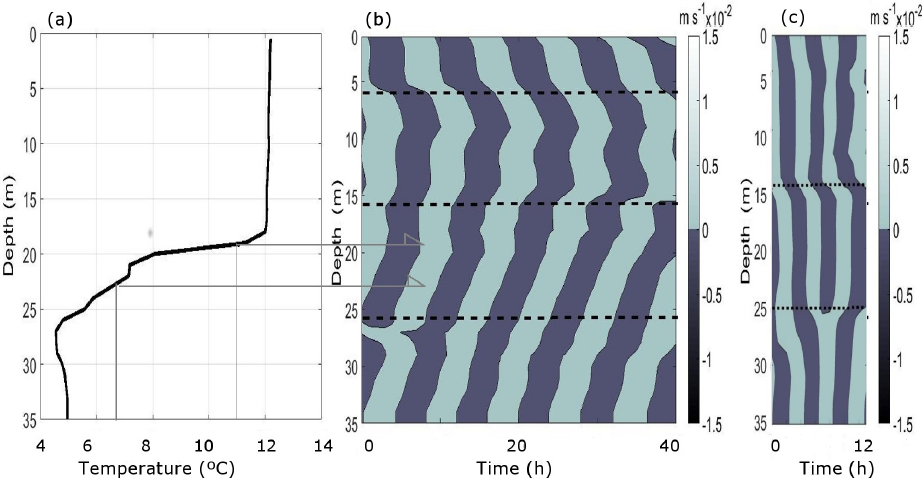
Figure 9. (a) Measured temperature profile in 2013 showing the depths at 6.8 and 11 ◦ C. (b) Filtered horizontal velocity along the main axis of the lake for the internal seiche of 7h and (c) filtered velocity for the internal seiche of 4h in 2013. The dashed horizontal lines indicate the interfaces between layers.